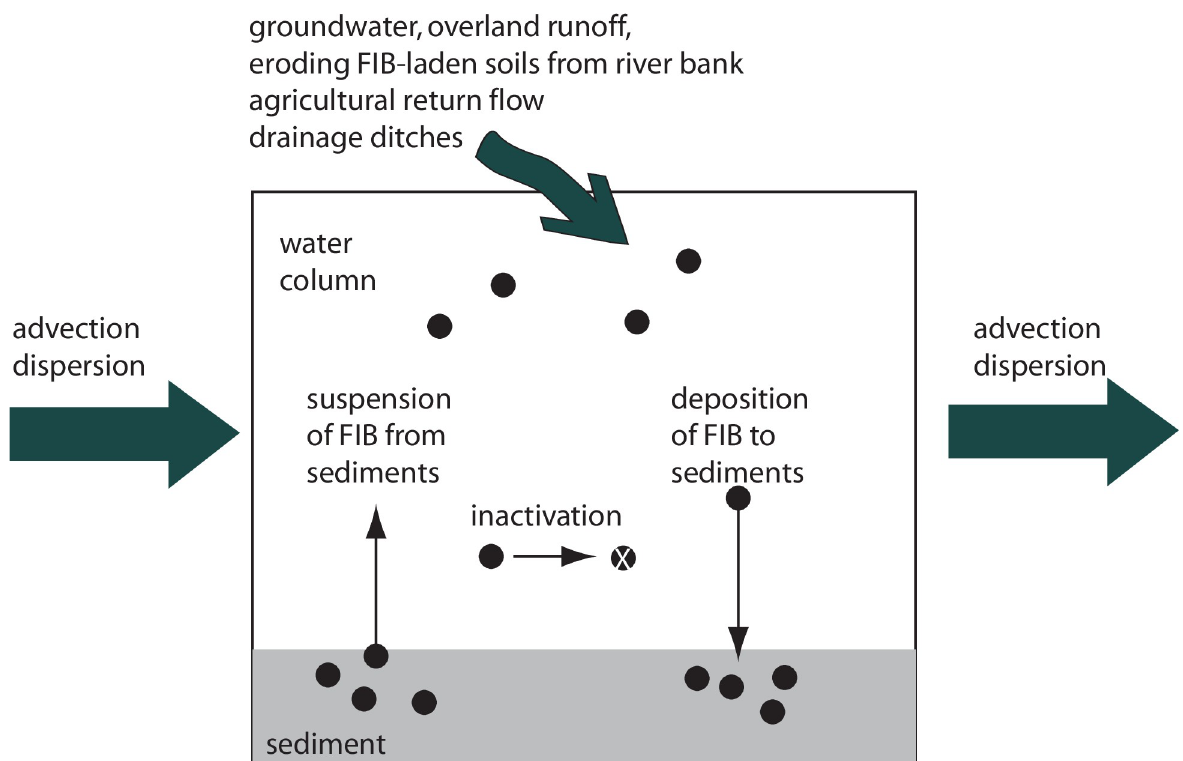
Fig 2. Conceptual model illustrating the endogenous and exogenous inputs and losses of FIB to a water parcel in the Hanalei River.